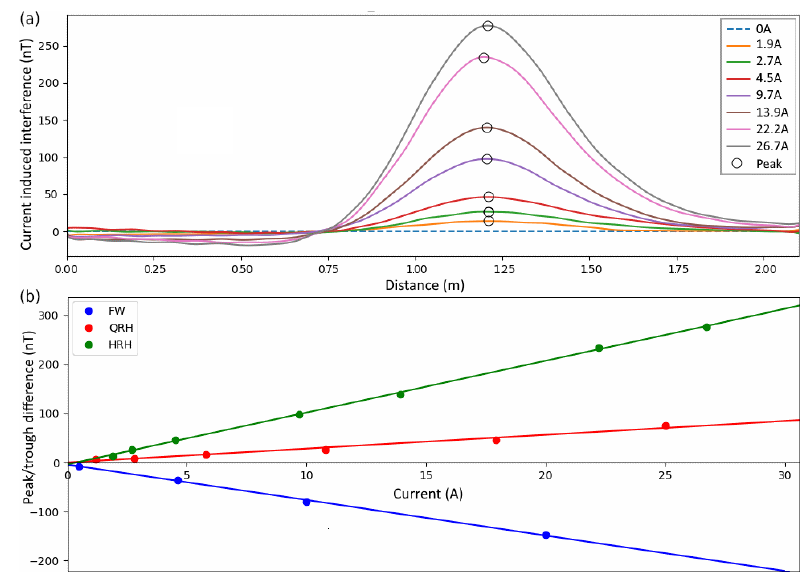
Figure 9. (a) The interference profiles for the HRH (with the residual removed) minus the calculated interference profile for a current of 0A. Circles indicate that current-related peak values are plotted with respect to current in panel (b) . (b) A plot of the peak and trough values minus the calculated 0A peak and trough for the FW, QRH, and